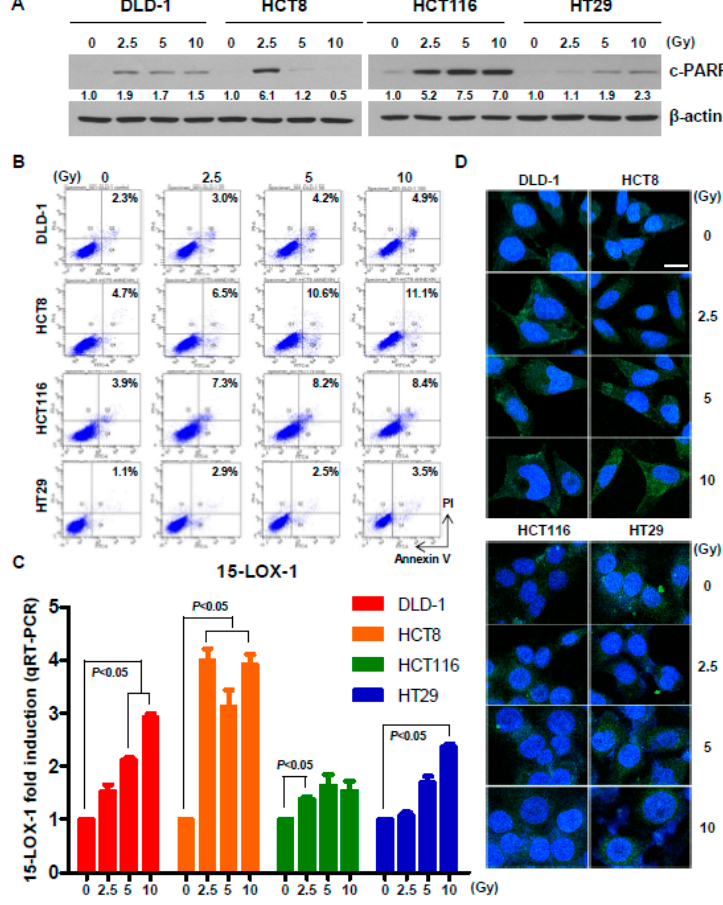
Figure 2. Radiation induces cell death and upregulates 15-LOX-1. ( A ) Twenty-four hours after irradiation at the indicated doses, cleaved PARP levels were measured by Western blotting, and ( B ) the number of Annexin V-positive cells increased, as demonstrated by flow cytometry. ( C ) Twenty-four hours after irradiation, the mRNA level of 15-LOX-1 in CRC cells was quantitated by qRT-PCR. ( D ) The 15-LOX-1 protein level was visualized by immunocytochemistry 24 h after irradiation. 2.3. The Absence of 15-Lox-1 Decreases Radiation Sensitivity